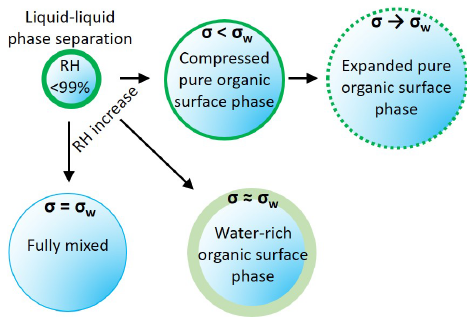
Figure A1. Schematic representation of the three model variants. AIOMFAC-EQUIL treats the droplets as a fully mixed single phase, with the surface tension of the wet droplet sharply approaching σ w . The phase-separated variants considered a surface phase that is water rich, with surface tension close to σ w , and a surface phase that excludes water, behaving as an organic surface film, with σ<σ w . The output from these scenarios is shown in Fig. A2.